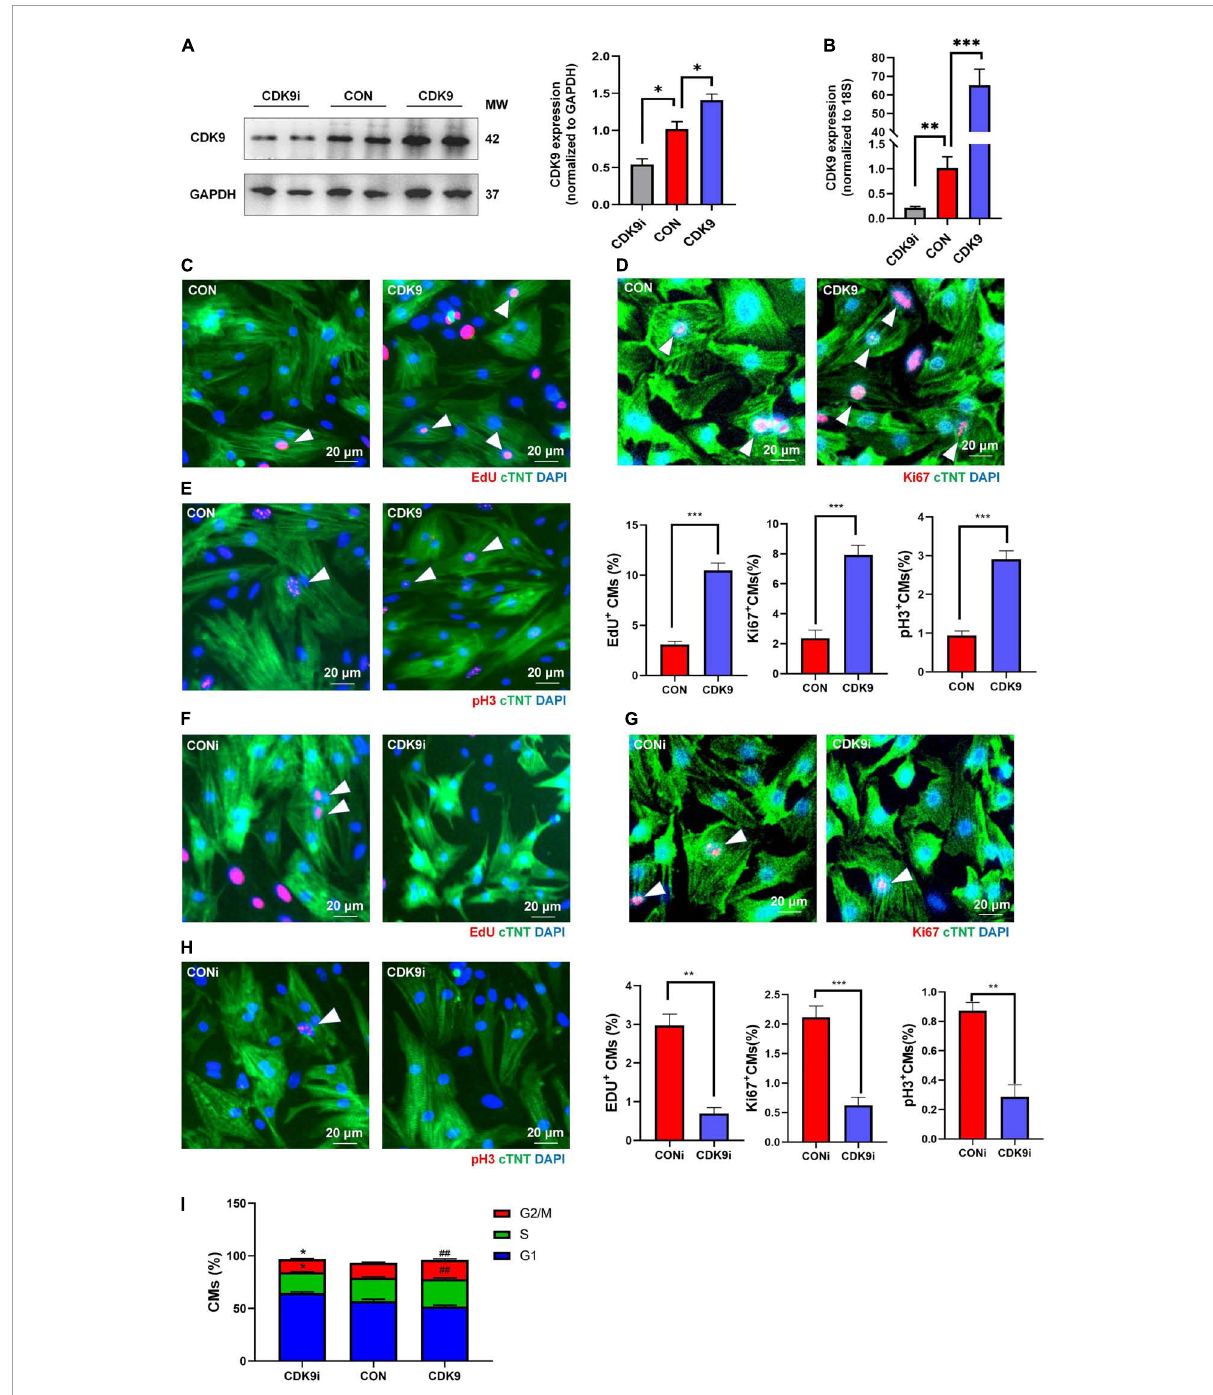
FIGURE3 CDK9 promotes cardiomyocyte (CM) proliferation in vitro . (A) Knockdown and overexpression of CDK9 proteins confirmed by western blot in neonatal CMs treated with Ad5: cTnT-CON, Ad5: cTnT-CDK9 or Ad5: cTnT-CDK9 RNAi. (B) Knockdown and overexpression of CDK9 mRNA confirmed by qRT-PCR. (C–E) CM proliferation quantified in neonatal CMs transfected with Ad5: cTnT-CON or Ad5: cTnT-CDK9 by immunofluorescence for DNA synthesis (C) , cell-cycle activity (D) , and mitosis (E) ( n = 6). (F–H) CM proliferation was quantified in neonatal CMs treated with Ad5: cTnT-CDK9 RNAi by immunofluorescence for DNA synthesis (F) , cell-cycle activity (G) , and mitosis (H) ( n = 6). (I) CM cell cycle activity was detected by flow cytometry analysis after transfected with Ad5: cTnT-CON RNAi, Ad5: cTnT-CDK9, or Ad5: cTnT-CDK9 RNAi (CDK9i) ( n = 3). White arrows in representative pictures point to the proliferating CMs; scale bars, 20 µ m; CMs indicate cardiomyocytes, MW indicates molecular weight; statistical significance was calculated with the unpaired Student t -test; data are presented as mean ± SEM, ∗ P ≤ 0.05, ∗∗ P ≤ 0.01, ## P ≤ 0.01, ∗∗∗ P ≤ 0.001; each dot indicates a biological